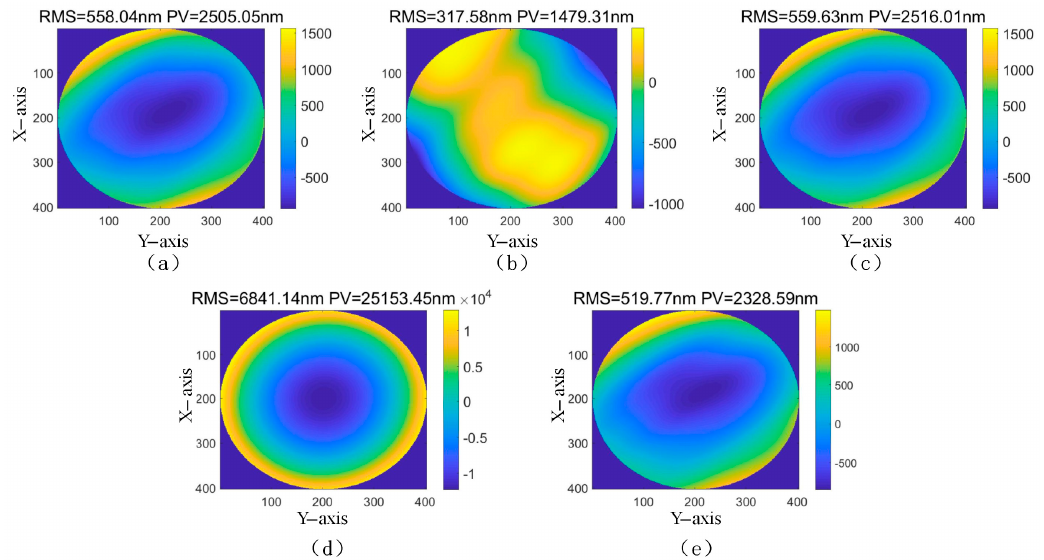
Figure 7. Experiment results of the planar window glass (after removing the first three terms): ( a ) EPCM; ( b ) PM with systematic errors; ( c ) PM after eliminating systematic errors; ( d ) MPMD; ( e ) Interferometer.